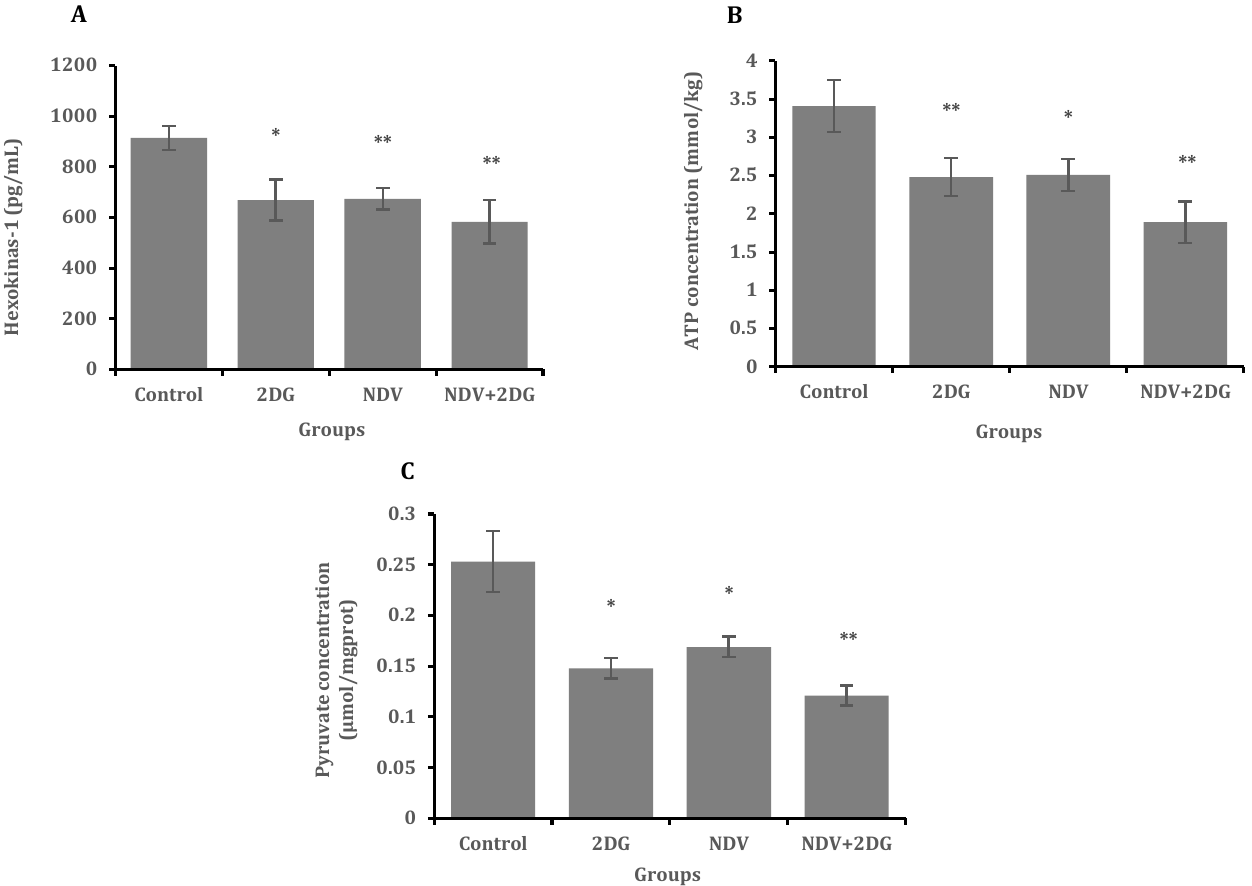
Figure 2. NDV and 2DG effect on Glycolysis pathway and products on breast cancerin female mice. A) hexokinase-1 (HK-1) quantification. B) ATP concentration. C) pyruvate contents. ∗∗ 𝑃 < 0.01 and ∗ 𝑃 < 0.05 versus control